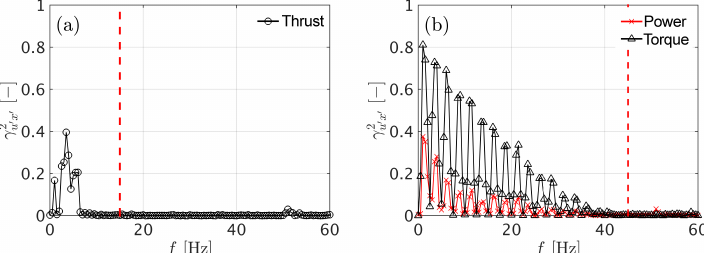
Figure A2. Magnitude-squared coherence of filtered hot-wire data and thrust (a) as well as power and torque (b) . Used here were 500 Hanning windows with 50% overlap, as suggested by Carter et al. (1973). Panel (b) shows regular drops of γ 2 , which are caused by a filter function within the control algorithm of the model turbine. Since the controller affects the electrical circuit, there is a direct connection to the electrical current and therewith to the power and torque. Consequently, the effect of the filter is clearly visible in this